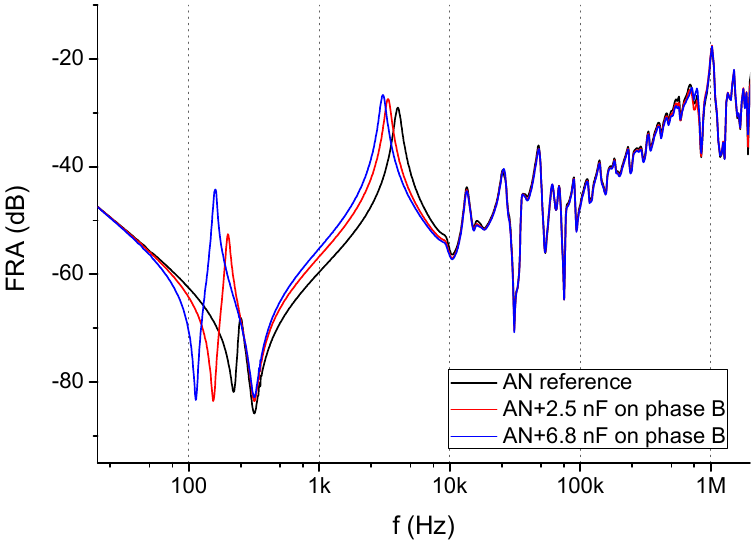
Figure 9. FR of HV phase A of a 250 MVA, 400/110/30 kV autotransformer with additional capacitances installed on HV phase B.